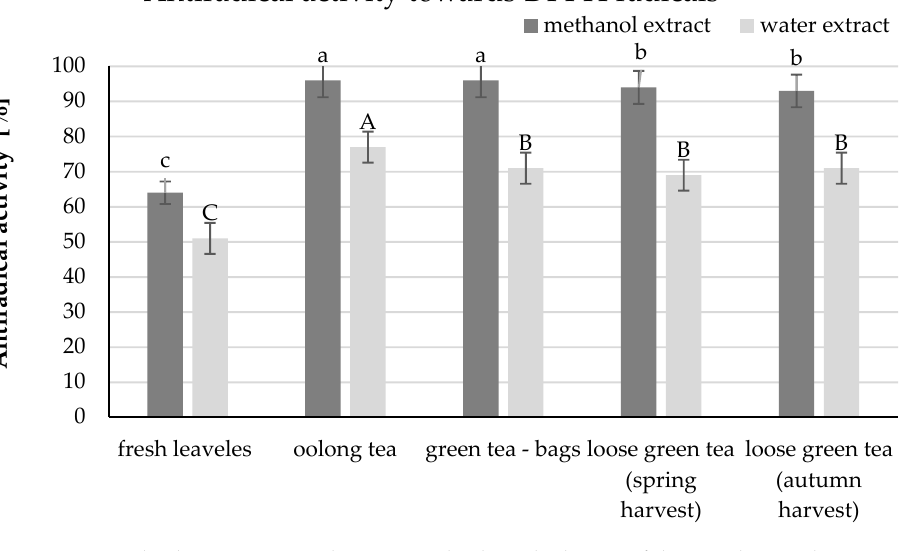
Figure 3. Antiradical activity towards DPPH radicals in the leaves of the tea plant and various types of tea. The same letter a, b, c indicates no statistically significant differences between the mathanol extracts, and A, B, C—between the water extracts of the analyzed teas.